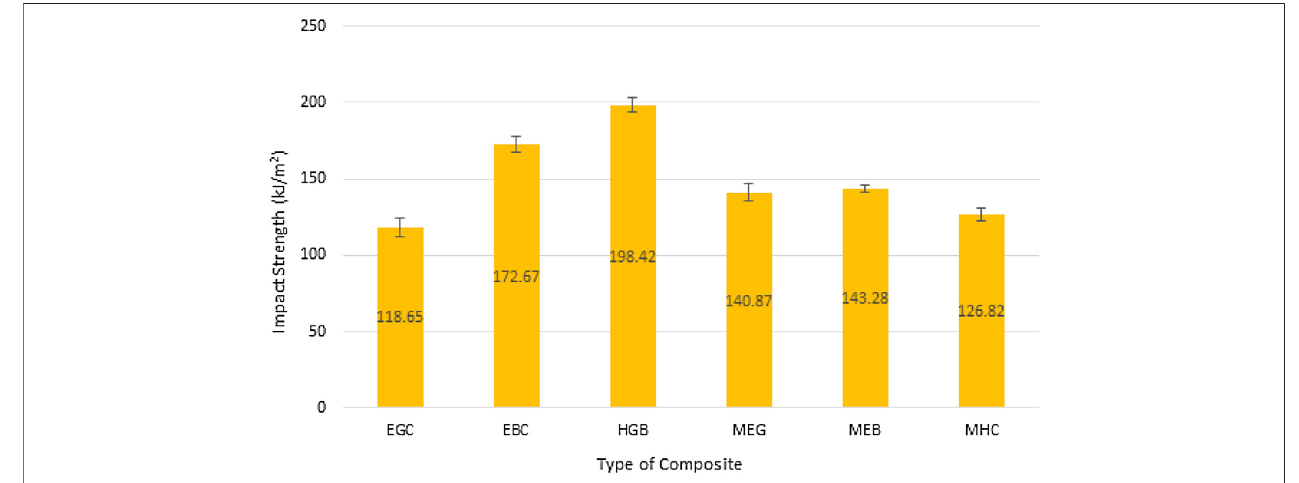
FIGURE 5 | Impact strength of different